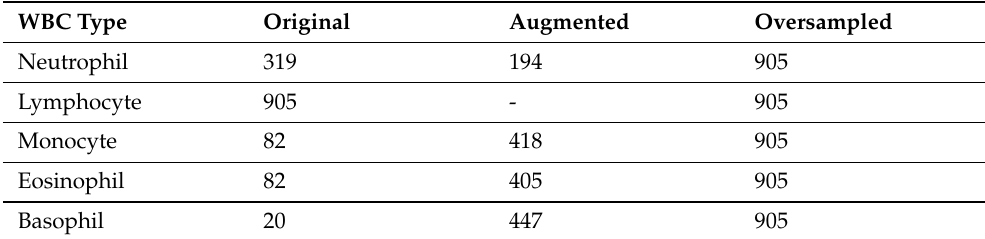
Table 5. Sample count after over-sampling of